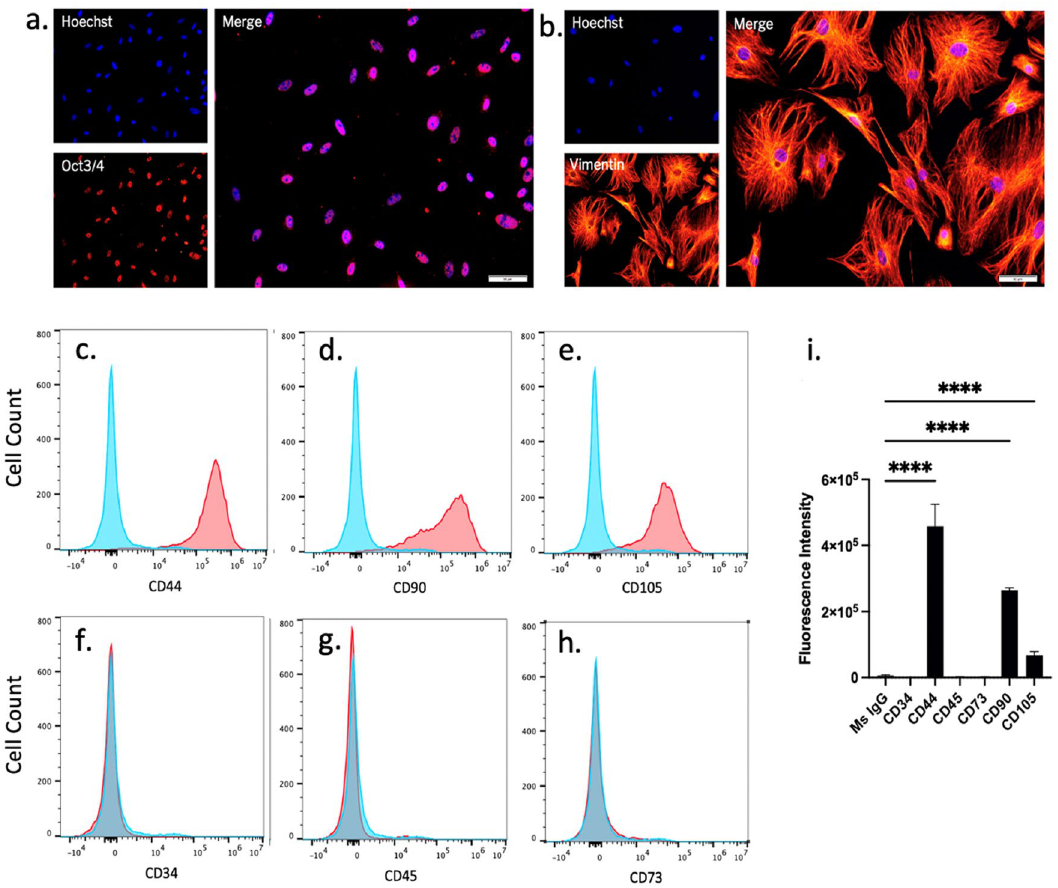
Figure 1. Characterization of adipose-derived mesenchymal stromal cells isolated from mouse visceral fat and expanded in culture. AdMSCs express the ( a ) undifferentiated cell marker Oct3/4 and ( b ) the structural protein Vimentin. AdMSCs express ( c ) CD44, ( d ) CD90 and ( e ) CD105 but not ( f ) CD34, ( g ) CD45 or ( h ) CD73 (red histograms) compared to IgG control (blue histograms). ( i ) Fluorescent intensities of AdMSC profile quantified in FlowJo. Scale bar = 50 µM. Representative histograms from three biological replicates with 10,000 events each. Two-way ANOVA and post-hoc Tukey test, error bars = SEM, **** p <